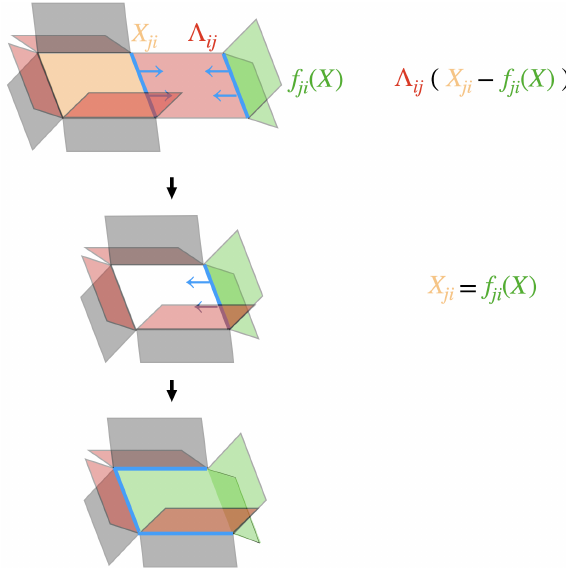
Figure 11 . Integrating out massive fields in a BFT 2